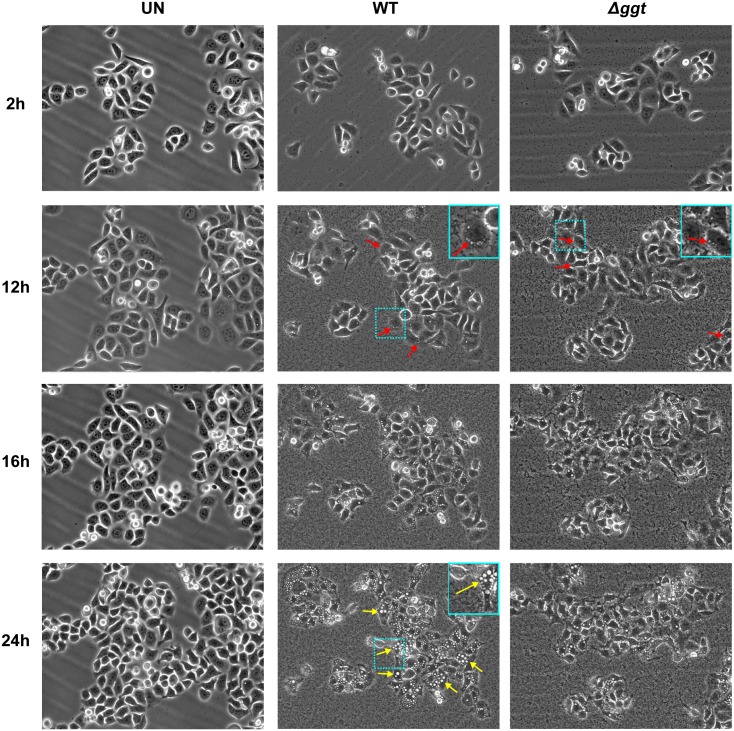
Live-cell micrographs of H. pylori-infected AGS cells.AGS cells were infected with H. pylori WT or Δggt at MOI of 1:100 over a 24 hour period and the process of infection was recorded using Biostation IMQ. Uninfected cells served as control. Micrographs shown here are at 2h, 12h, 16h and 24h time-points. Perinuclear vacuoles are indicated with red arrows. Large vacuoles are indicated with yellow arrows. Insets show a close-up of vacuole position and size in AGS cells. (See S2 Fig and S1–S3 Videos respectively for the full time course).